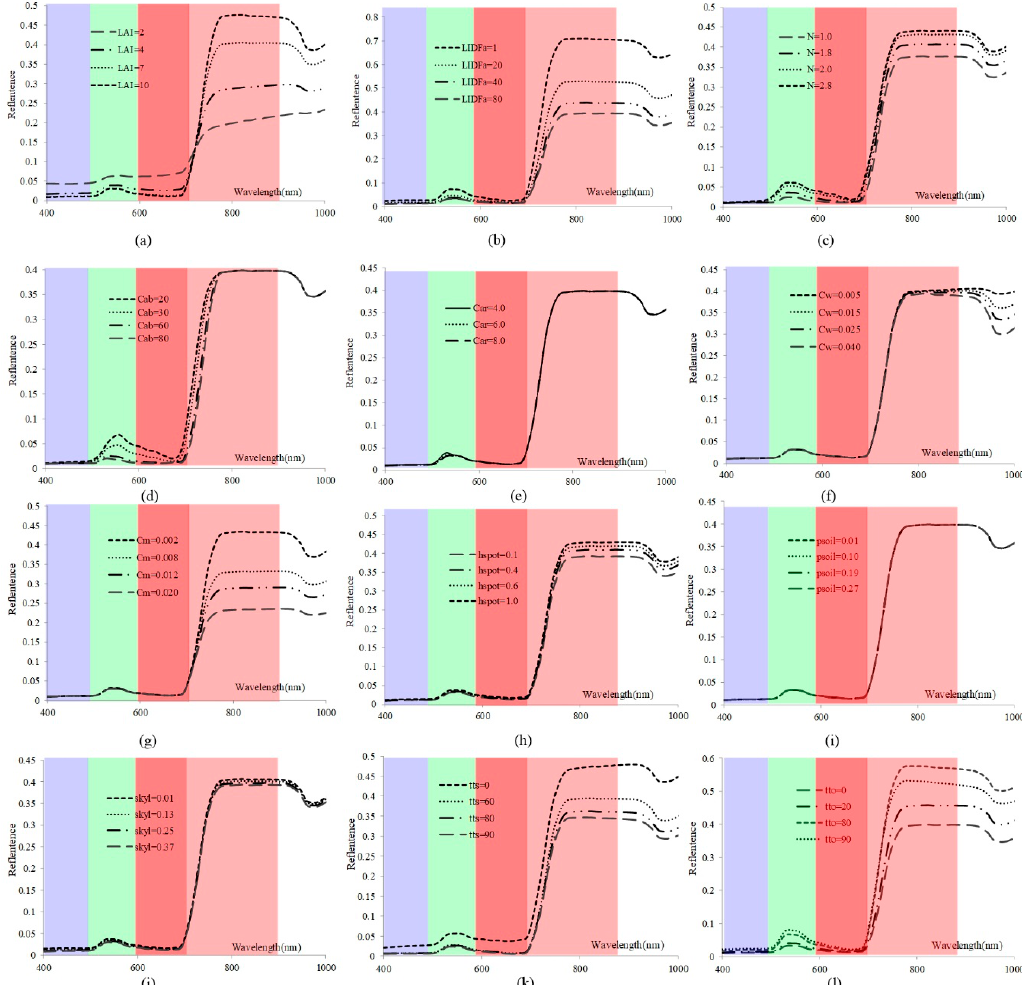
Remote Sens. 2019 , 11 , x FOR PEER REVIEW Figure 5. Results of the sensitivity analysis for the 12 input parameters to which PROSAIL is sensitive.